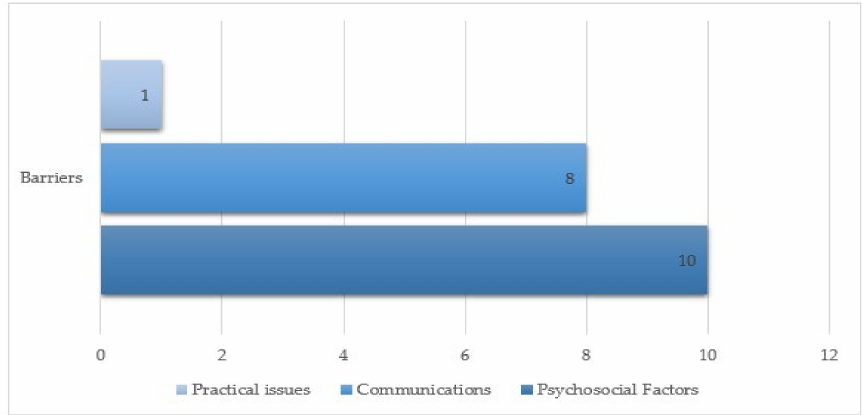
Figure 2. Distribution of barriers to COVID-19